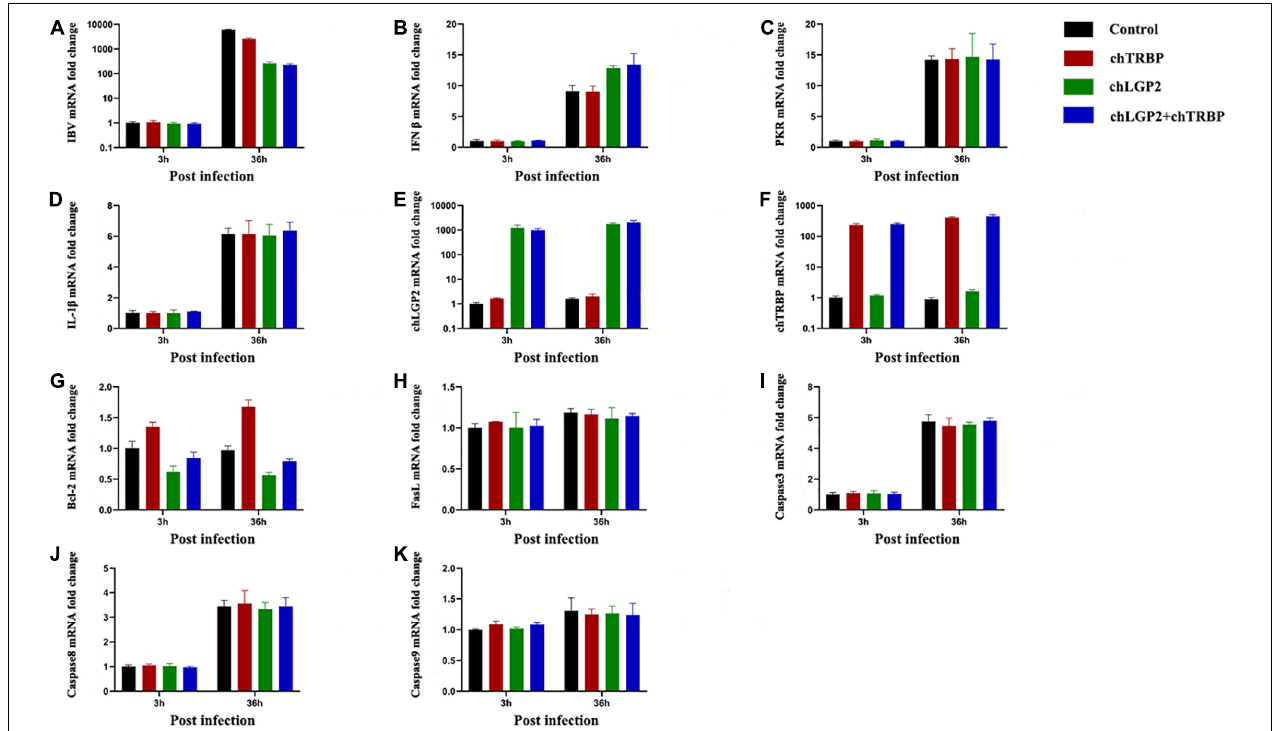
FIGURE 6 | Effects of chTRBP overexpression and co-expression of chTRBP and chLGP2 on IBV replication and expression of immune-related genes: (A) IBV; (B) IFN- β ; (C) PKR; (D) IL-1 β ; (E) chLGP2; (F) chTRBP; (G) Bcl-2; (H) FasL; (I) Caspase3; (J) Caspase8; (K) Caspase9. Data are the mean values from three independent experiments, and error bars denote mean ±